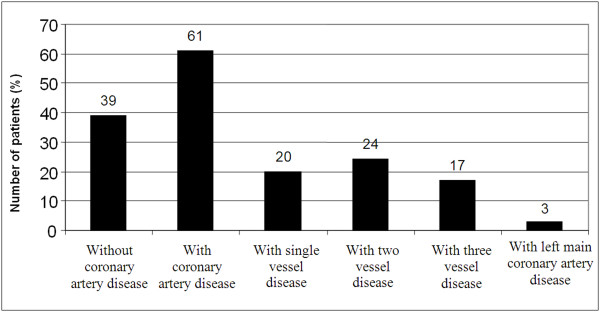
Coronary angiographic features of the patients included in the study.